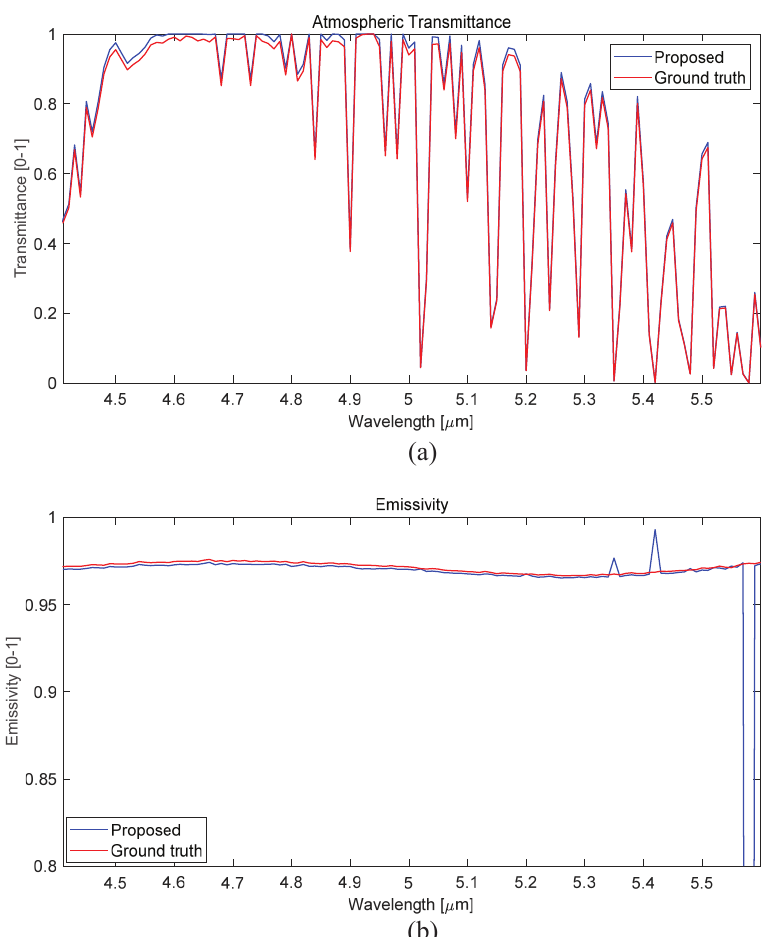
Figure 17. Separated atmospheric transmittance and emissivity: ( a ) a comparison of spectral atmo- spheric transmittance between the proposed method and ground truth, and ( b ) a comparison of spectral emissivity between the proposed method and ground truth.